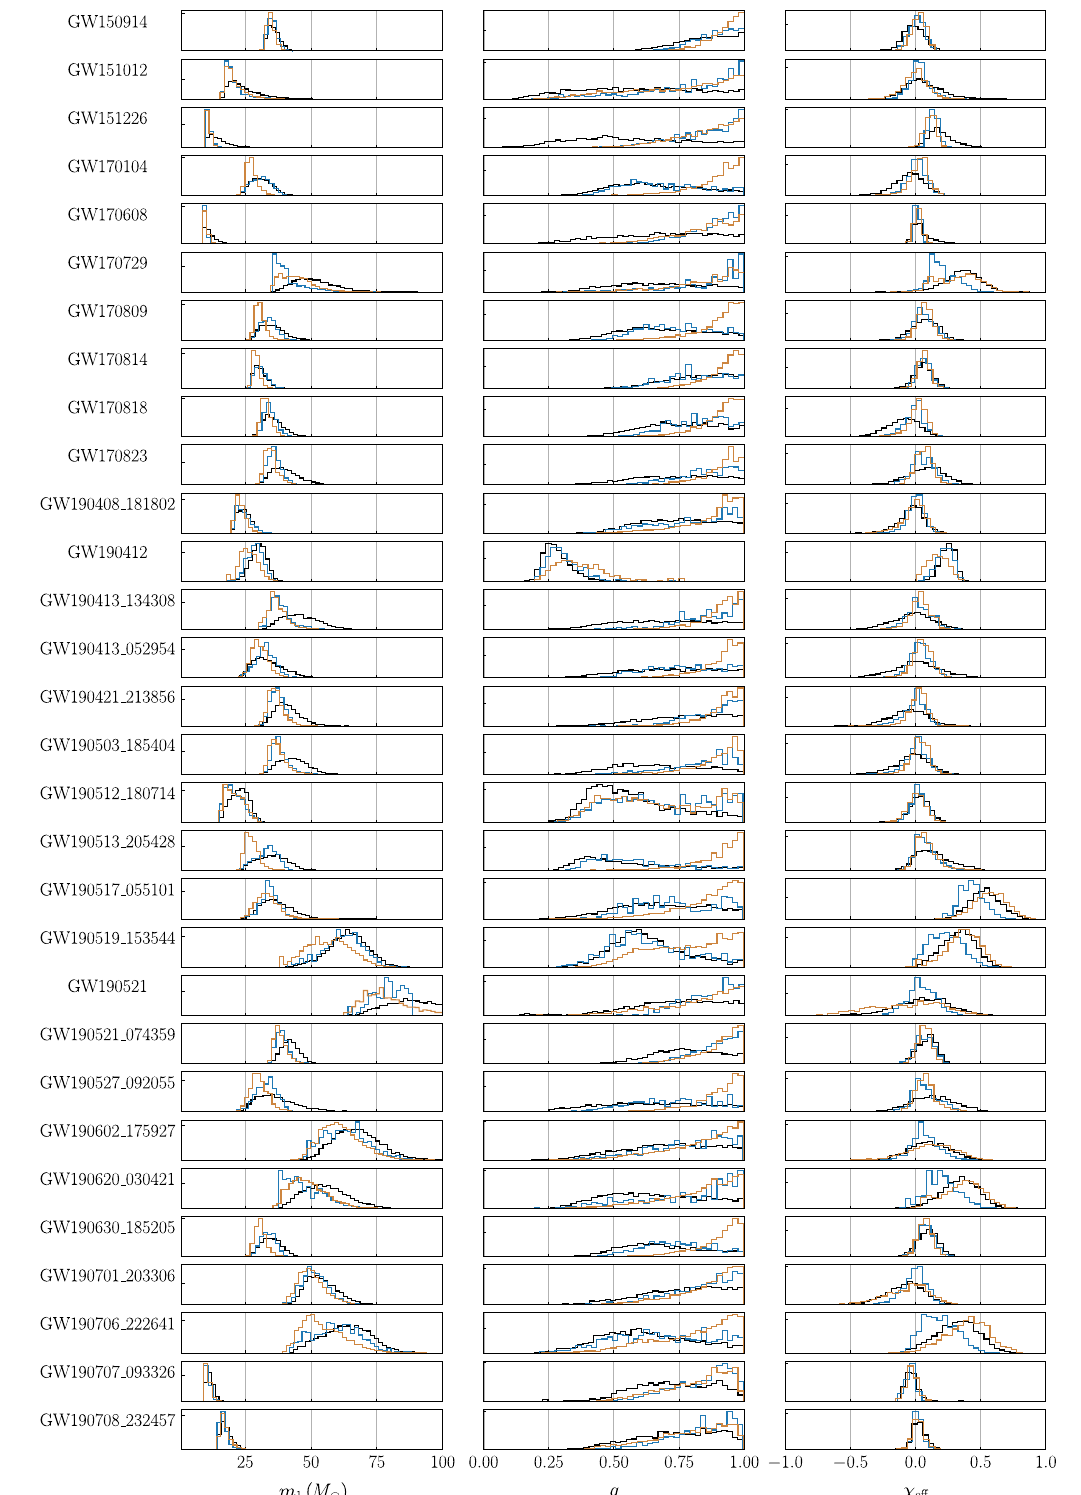
FIG. 28. Posterior distributions (black) for binary black hole events weighted by the population results from P OWER L AW +P EAK (blue) and F LEXIBLE MIXTURES